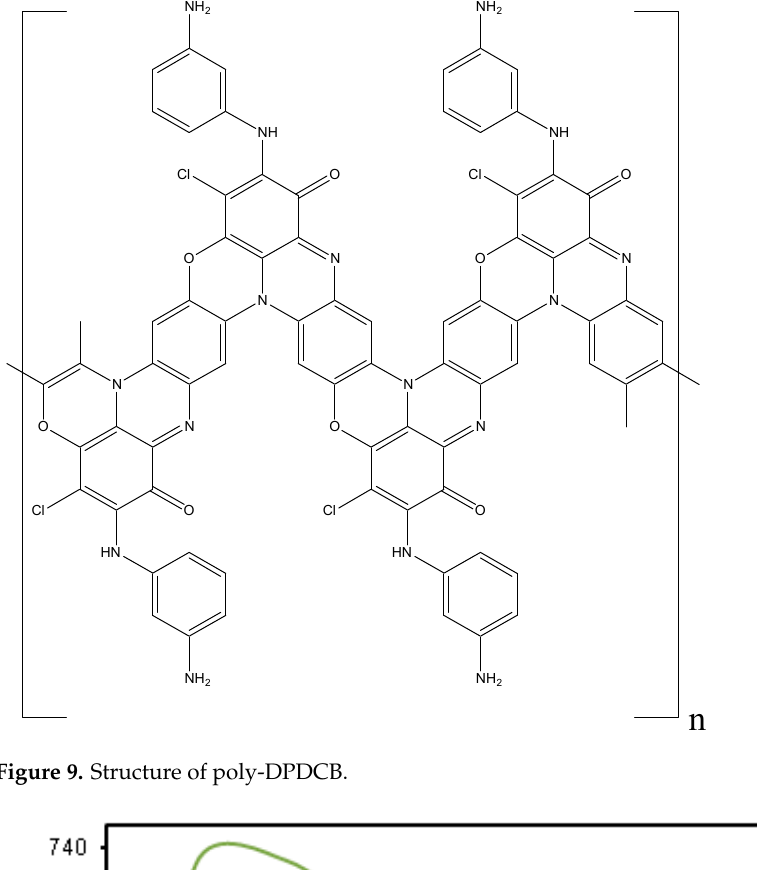
Figure 9. Structure of poly-DPDCB.